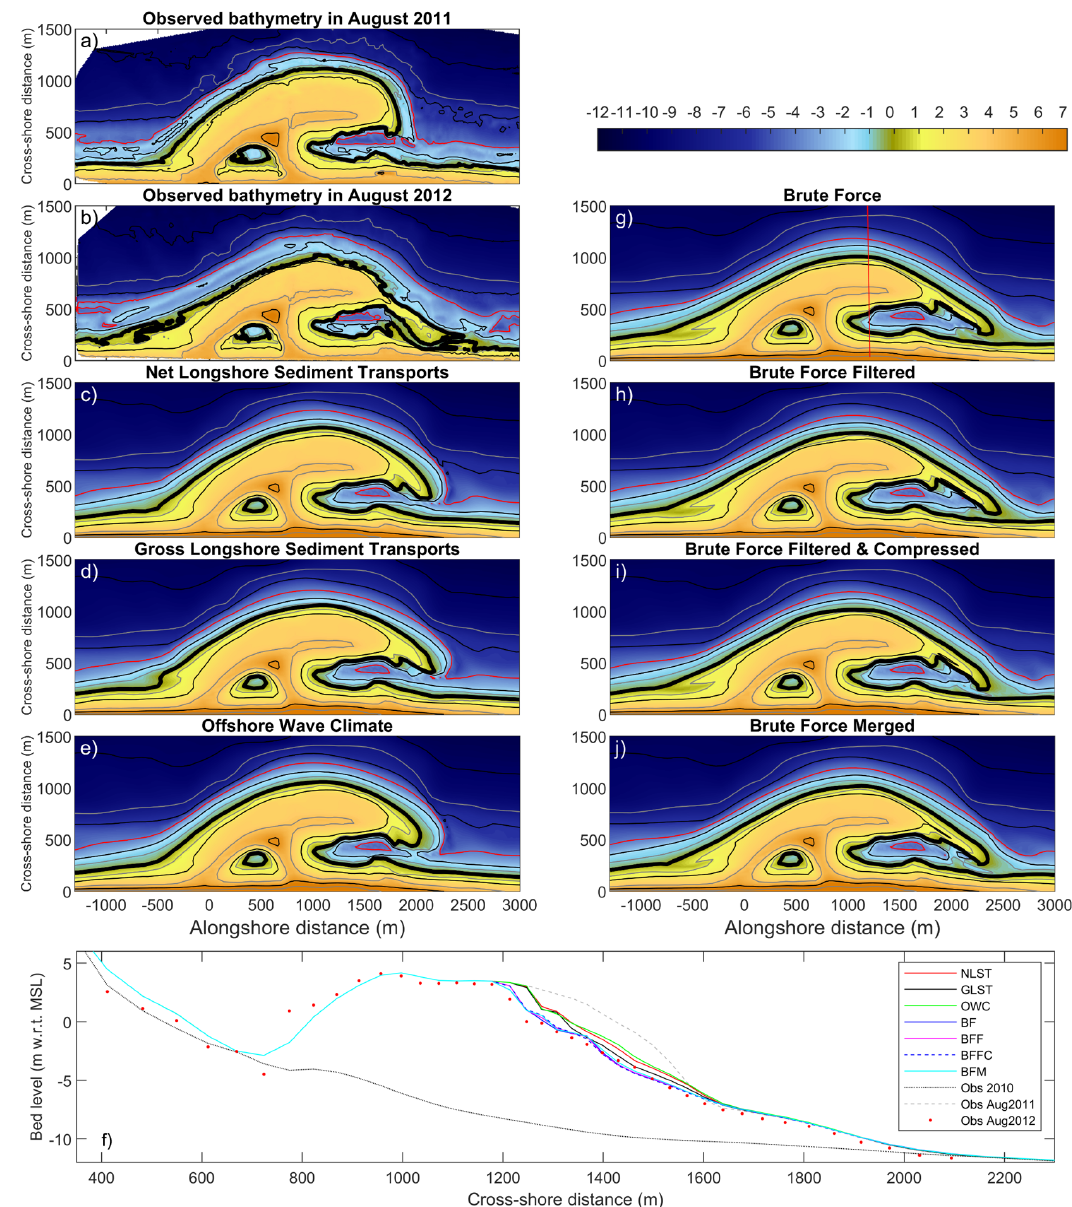
Figure 11. Observed and computed bed levels after one year: ( a ) observed bathymetry in August 2011, ( b ) observed bathymetry in August 2012, and the predicted bathymetries in August 2012 for ( c ) NLST, ( d ) GLST, ( e ) OWC, ( g ) BF, ( h ) BFF, ( i ) BFFC, ( j ) BFM. Cross-shore profiles for all observations and simulations are presented in ( f ) along the red transect shown in ( g ). The red line represents the − 4 m MSL depth contour, while the thick black line shows the 0 m MSL depth